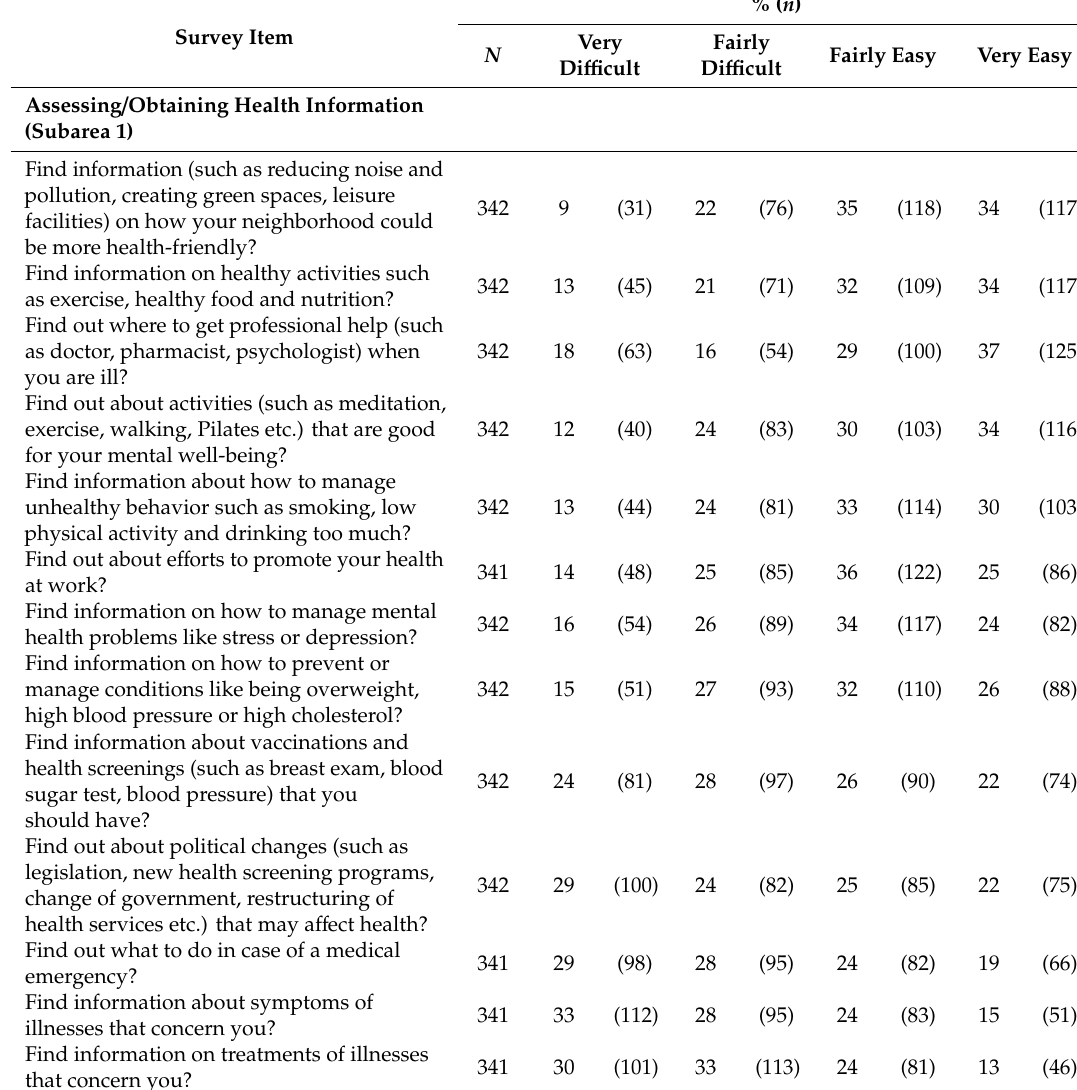
Table 2. Thai Asian Health Literacy Survey (AHLS) Response Frequencies ( N = 344) 1